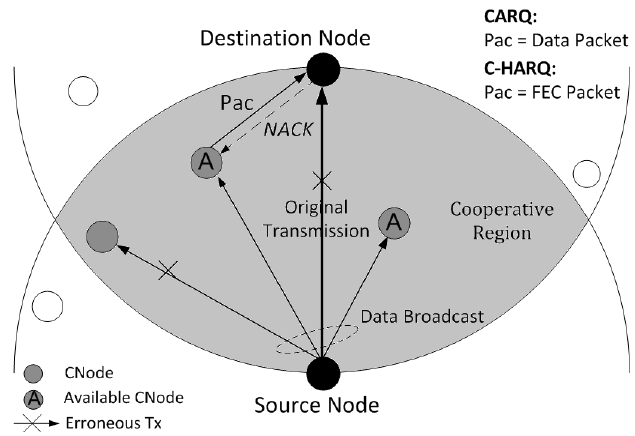
Figure 1. Network